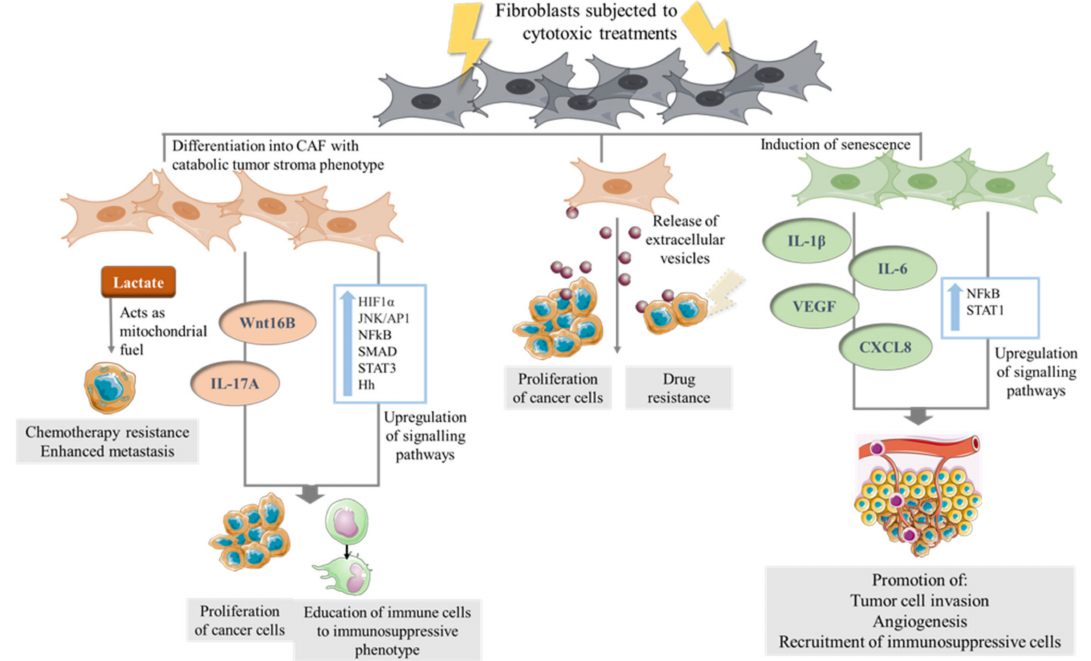
Figure 2. The direct effect of cytotoxic therapies on CAF. Fibroblasts in the TME of cancer cells which are subjected to cytotoxic therapies undergo transformation to a catabolic tumor stroma phenotype secreting metabolites such as lactate which in turn serves as mitochondrial fuel for cancer cells. Chemotherapy can stimulate stress-linked signaling pathways in CAF and the secretion cytokines lead to a microenvironment which in turn can promote cancer proliferation and educate immune cells to an immunosuppressive phenotype. Senescence induction in CAF have been shown to upregulate signaling pathways, leading to secretion of cytokines which promote tumor cell invasion, angiogenesis and the recruitment of myeloid-derived suppressor cells (MDSCs). CAF exposed to cytotoxic therapies release EVs which are taken up by cancer cells, leading to increased expression of genes associated with increased proliferation and drug